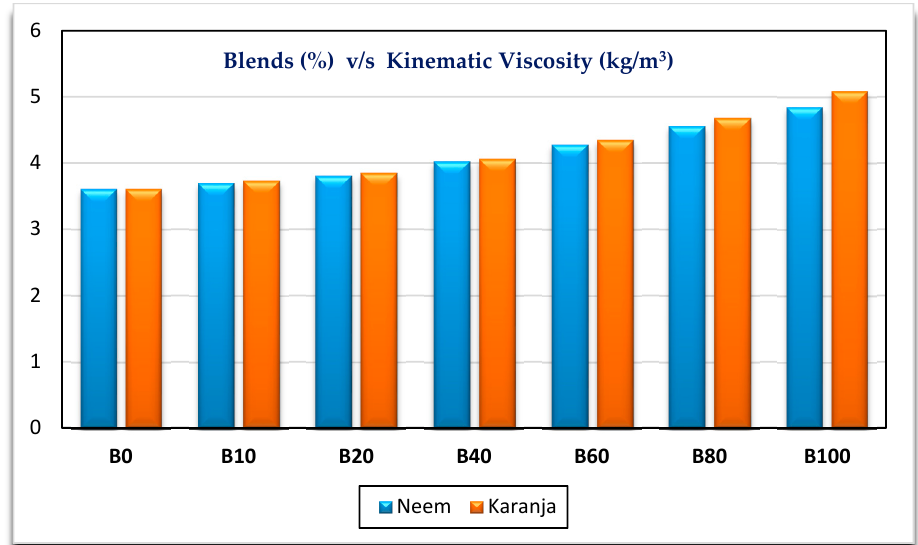
Figure 3. Variation of kinematic viscosity with biodiesel-diesel blends.